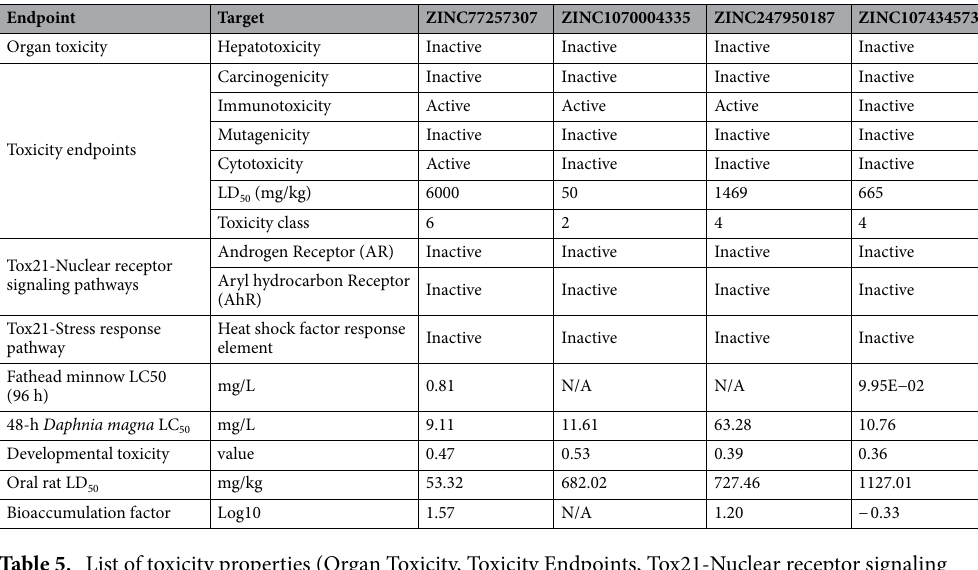
Table 5. List of toxicity properties (Organ Toxicity, Toxicity Endpoints, Tox21-Nuclear receptor signaling pathways, Tox21-Stress response pathway, Fathead minnow LC 50 (96 h), Developmental toxicity, Oral rat LD 50, Bioaccumulation factor ) of the selected 4 compounds.